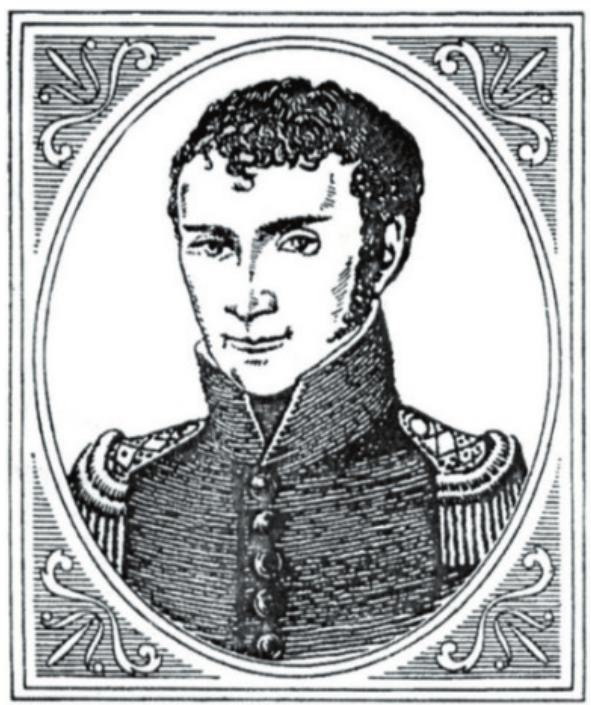
Figure 2. Portrait of Johann Wilhelm Ritter, wearing the uniform of the Bavarian Academy of Sciences. About 1804. Unknown artist. Taken from ref. [22] .